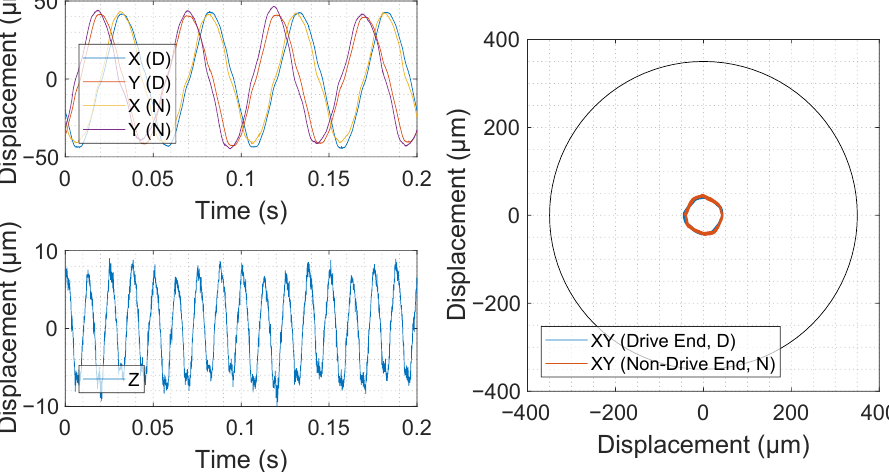
Figure 11. Rotor displacement measurement signals from two inductive displacement sensors placed at each end of the machine while the rotor is levitated and rotating at 1200